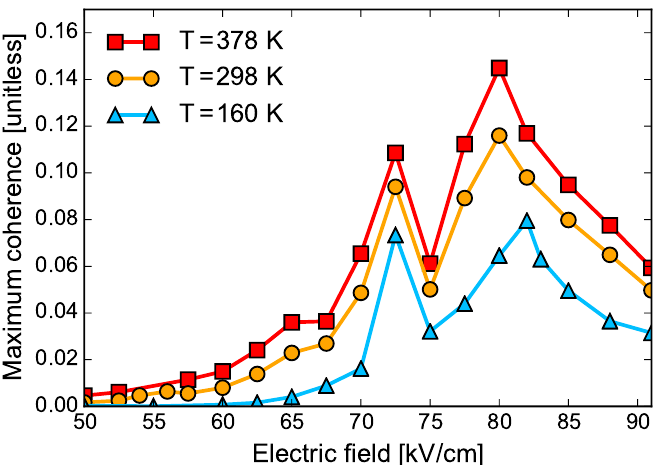
Figure 6. Ratio of the largest coherence to the largest occupation as a function of applied electric field. The peak around the design lasing field (80 kV/cm) is due to the coherence between the injector and upper lasing level. The peak around 72 kV/cm is due to two states localized in the injector